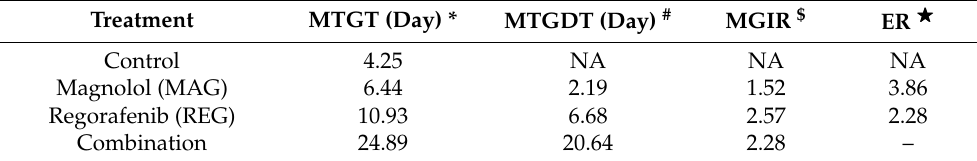
NA: not available. * Mean tumor growth time (MTGT): the time at which the tumor volume reached 500 mm 3 . # Mean tumor growth delay time (MTGDT): the mean tumor growth time of the treated group minus that of the control group. $ Mean growth inhibition rate (MGIR): the mean tumor growth time of the treated group/the mean tumor growth time of the sham control group. (cid:70) Enhancement ratio (ER): the mean growth inhibition rate of the combination group/the mean growth inhibition rate of the MAG or REG group. Table 3. Mean tumor growth inhibition rate and combination index in Hep3B tumor-bearing mice after treatment with magnolol, regorafenib, and a combination of both. Treatment